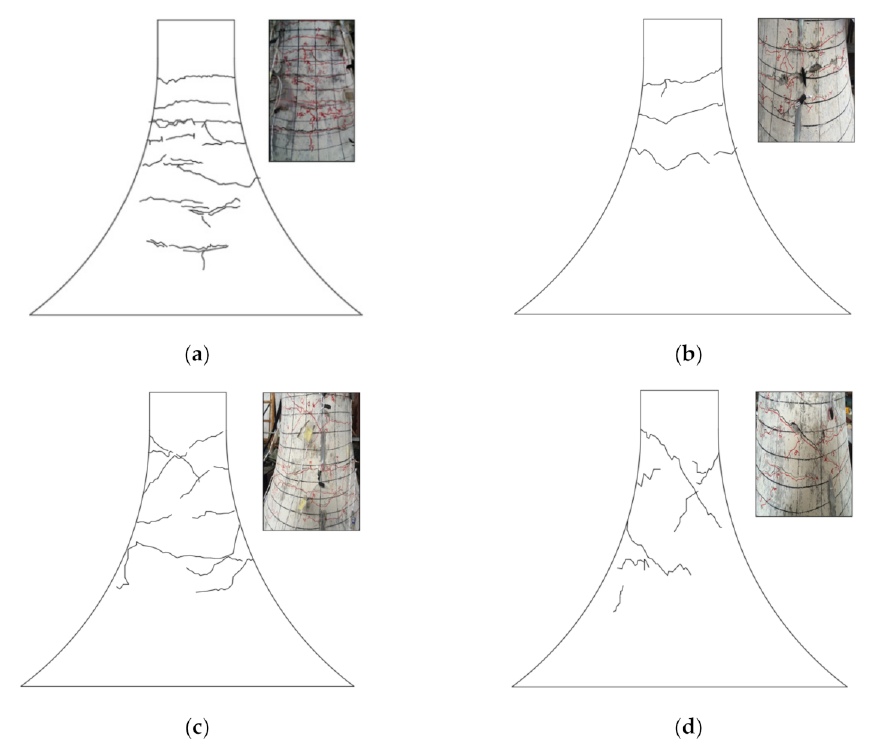
Figure 8. The failure mode of GD1 specimen: ( a ) East (forward), ( b ) West (reverse), ( c ) South (right side), and ( d ) North (left